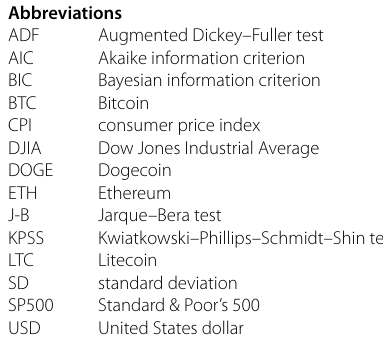
N = 2221 observations, p values reported for the statistical tests